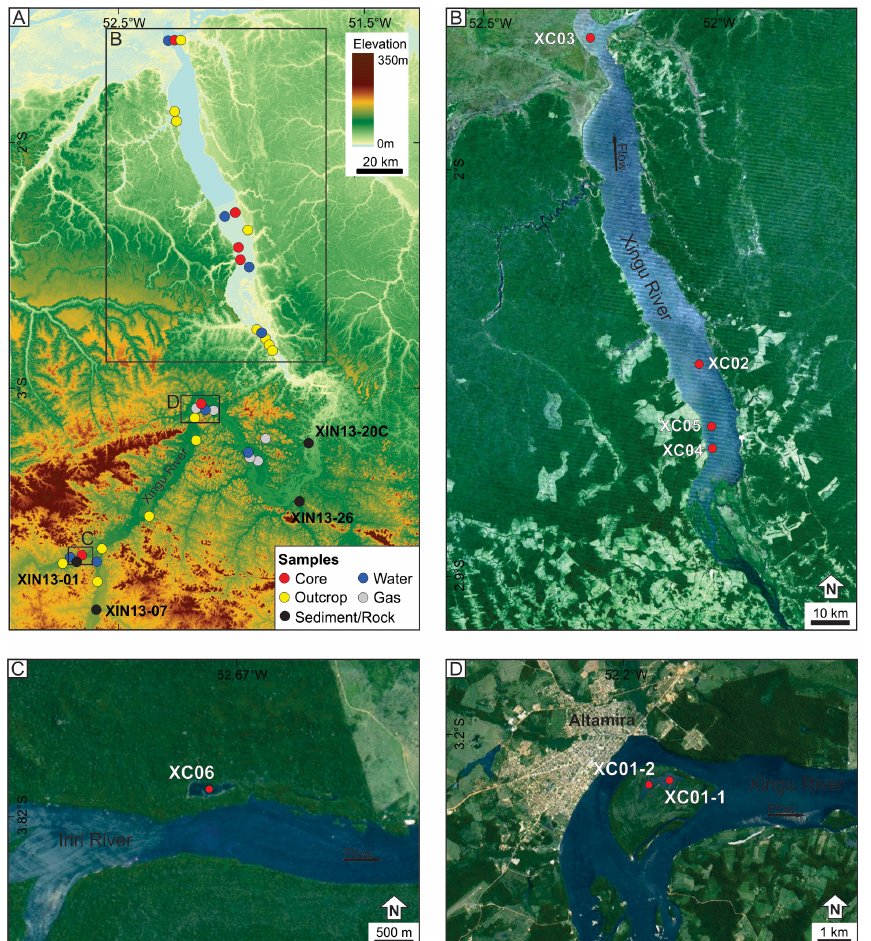
Figure 3. (a) Location of sediment cores (XC01 to XC06), surface sediments, rock and gas samples retrieved in the Volta Grande do Xingu and the Xingu ria. Elevation data from SRTM. (b, c, d) Sediment cores were collected in the ria and floodplain lakes. Satellite images from Google